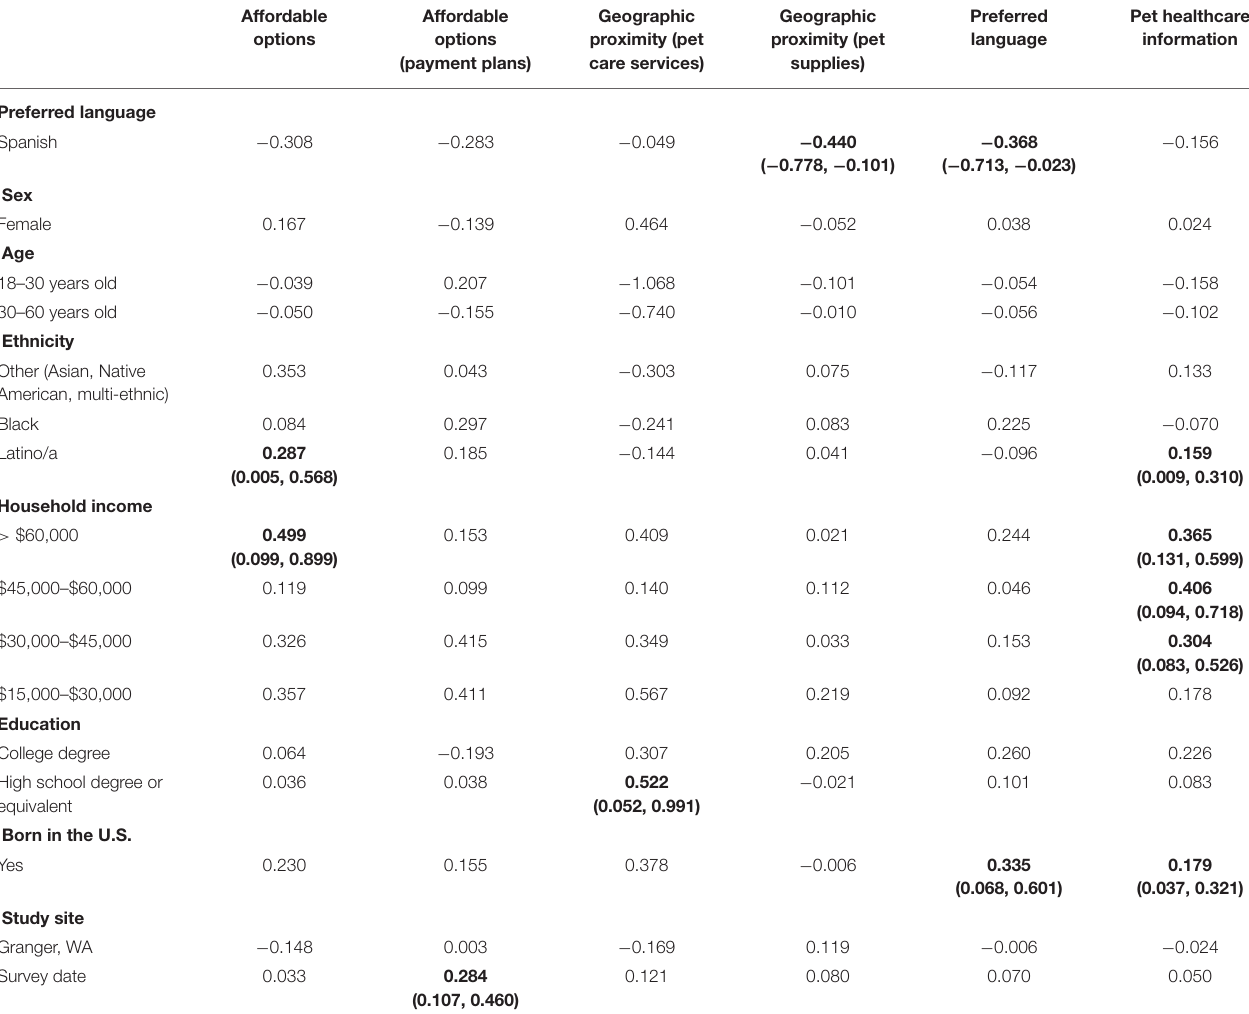
TABLE 6 | Generalized Estimating Equations to examine how the presence of PFL in a rural community influences disaggregated measures of perceived access to pet care ( N =